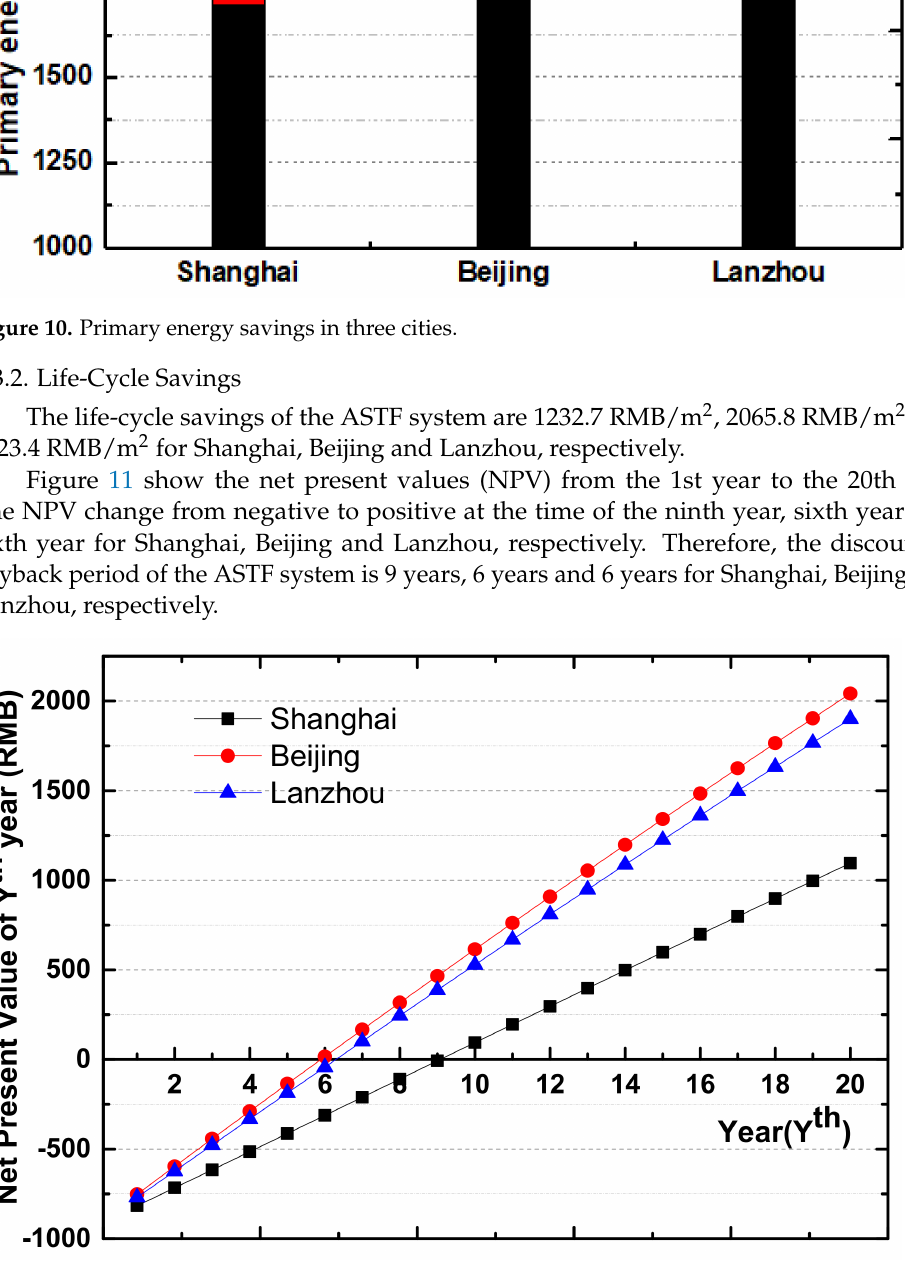
Figure 11. Net present value (NPV) at the time of Yth year over 20